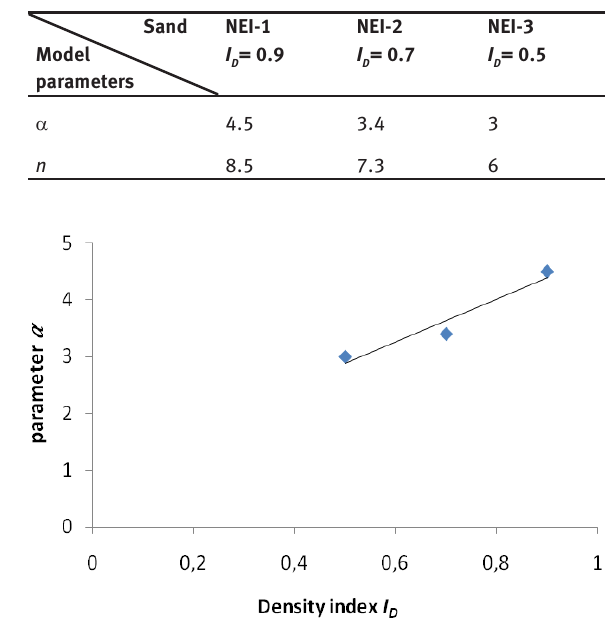
Figure 9: Evolution of the parameter a as a function of the density index I